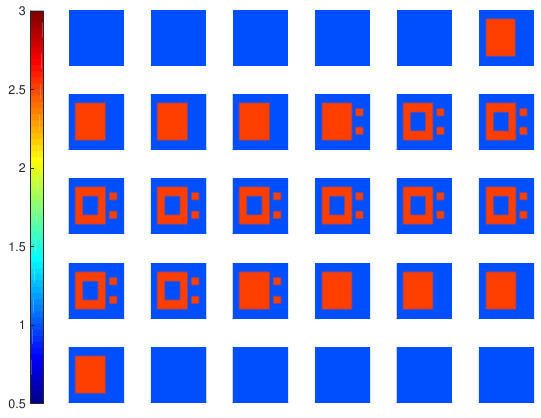
Figure 11. True permittivity profile (real part) for Example 3